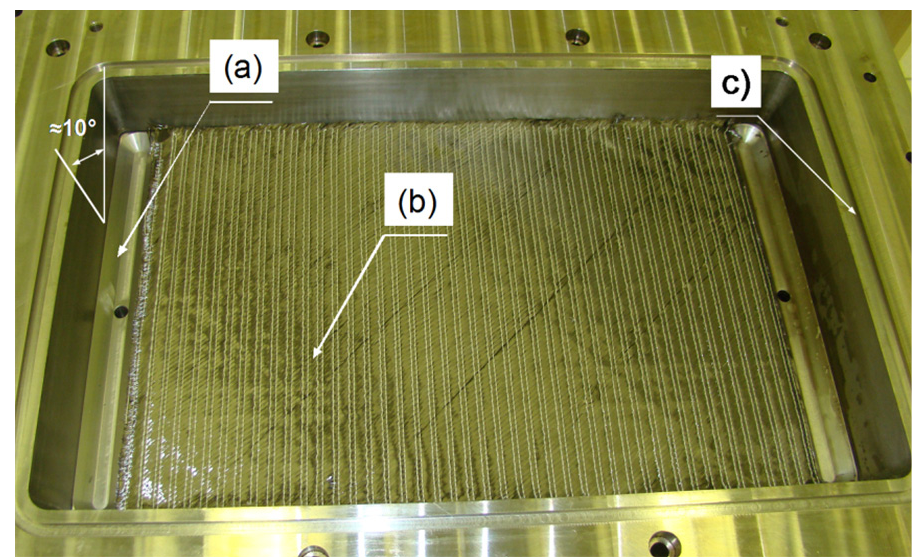
Figure 2. Female tool mold details: (a) line inlet gate; (b) carbon fiber preform; (c) sealing